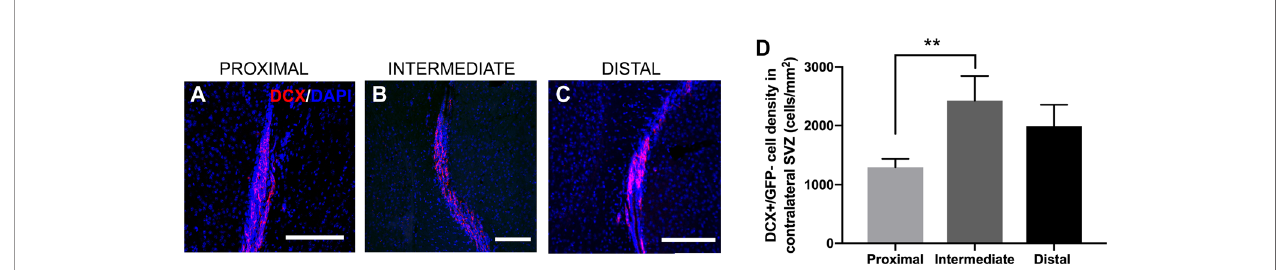
FIGURE 6 | LV-proximal GBM decreases the number of neuroblasts in the contralateral SVZ. (A – C) Representative images of DCX+ cells in the contralateral SVZ to the GBM in (A) LV-proximal (n = 7), (B) LV-intermediate (n = 3), and (C) LV-distal (n = 5) groups. Scale bar = 100 m m. (D) Quanti fi cation of DCX+ in the contralateral SVZ to the tumor between groups. Data is presented as mean ± SEM. ** p